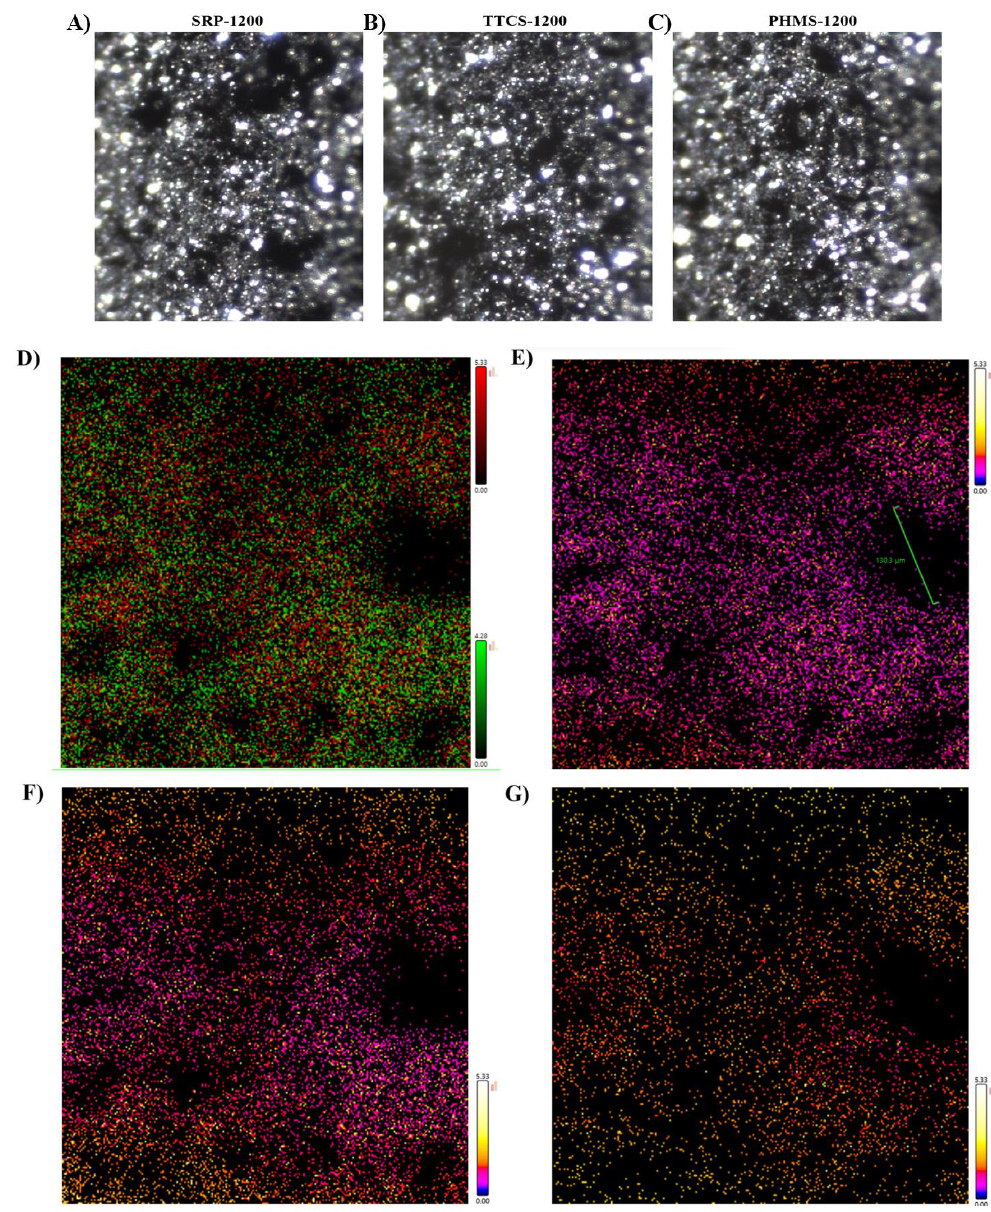
Figure 2. ( A – C ) Optical microscopic images with a field of view 800 × 800μm on SRP -1200, TTCS-1200, and PHMS-1200 fine powders. ( D ) Superimposed XPS micrographs of C 1 s and O 1 s . ( E ) Spa- tial distribution of C 1 s in SRP-1200. ( F ) Spatial distribution of O 1 s in SRP-1200. ( G ) Spatial distri- bution of Si 2 p in SRP-1200. (The field of view for the XPS micrographs is 400 × 400 μm) .